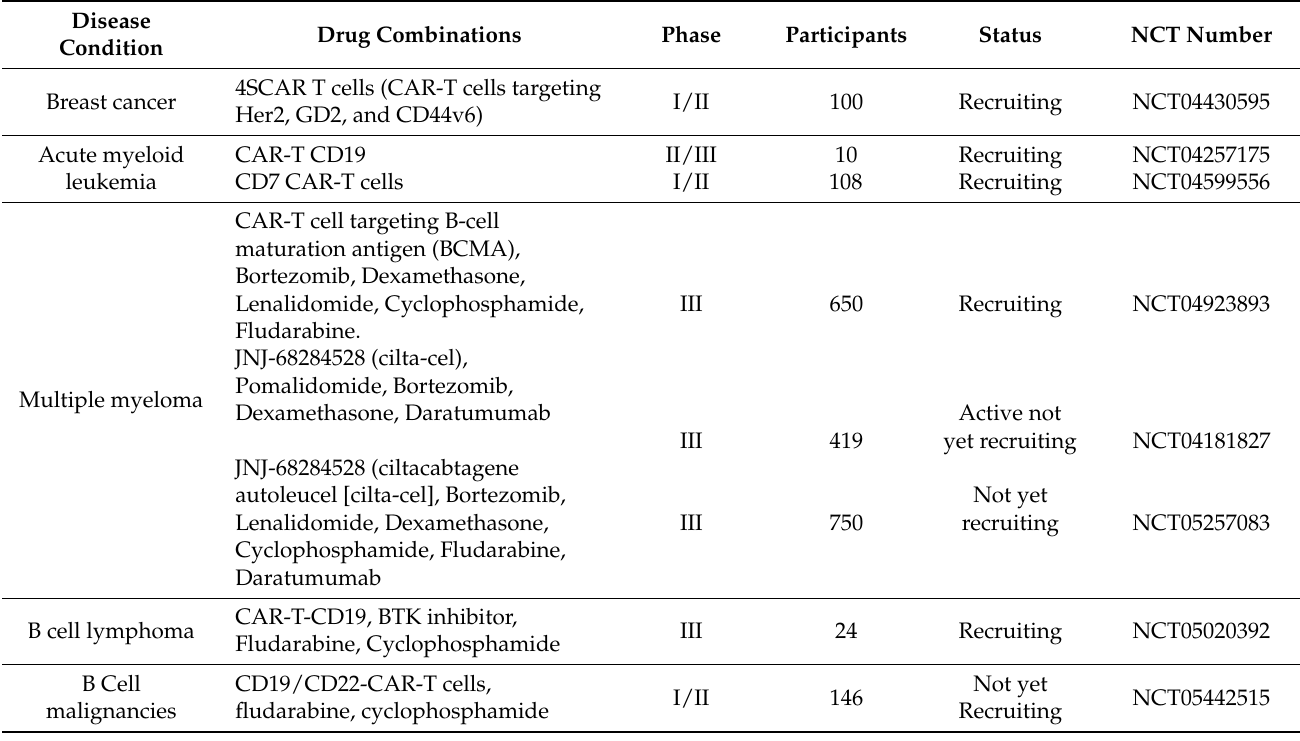
Table 2. Selected CAR T therapies in clinical trials. Data source ClinicalTrials.gov (www.clinicaltrials.gov, accessed on 25 June